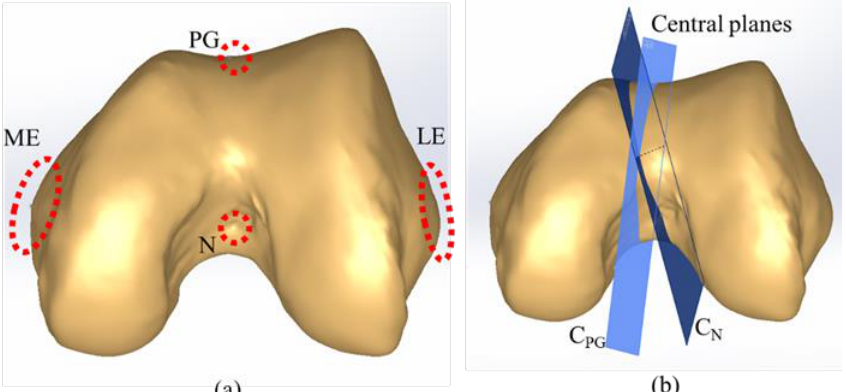
Figure 4. ( a ) N, PG, and multiple lateral and medial points for the modified Whiteside’s line. ( b ) Central planes defined using (PG, KC, FHC) and (N, KC, FHC). Similarly, the perpendicular distance between each medial point and C PG is calculated. The points corresponding to the largest perpendicular distances on each side are selected to define the aTEA. The chosen points define a repeatable aTEA, because the highest point